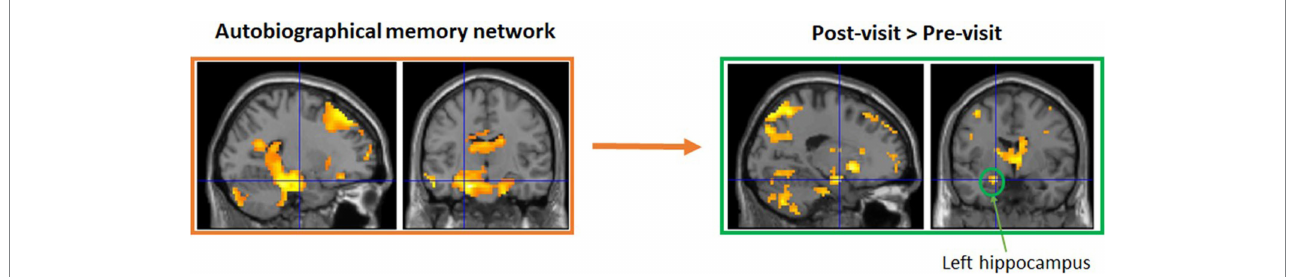
FIGURE 1 A small sub-group also took part in functional MRI brain scanning at Trinity College Institute of Neuroscience to test for structural and functional brain changes as a result of the intervention. Functional imaging data are currently being analyzed (Viard et al., in preparation). Initial results suggest the classical autobiographical memory network (including the precuneus, medial frontal and lateral temporal gyri, and hippocampi) was activated for pre- and post- visits separately. Direct comparisons showed greater activation for post-visit in left superior medial frontal gyrus, precuneus, and anterior hippocampus, compared to